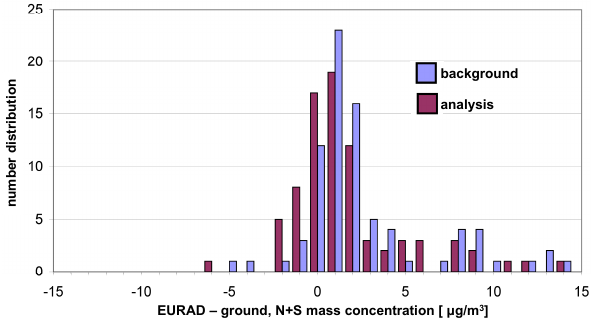
Fig. 3. Number distribution of differences in nitrogen and sulphur mass concentrations for 81 coincidences with EMEP stations in 8 European countries within July to November 2003 for both the background (blue) and the analysis (purple)